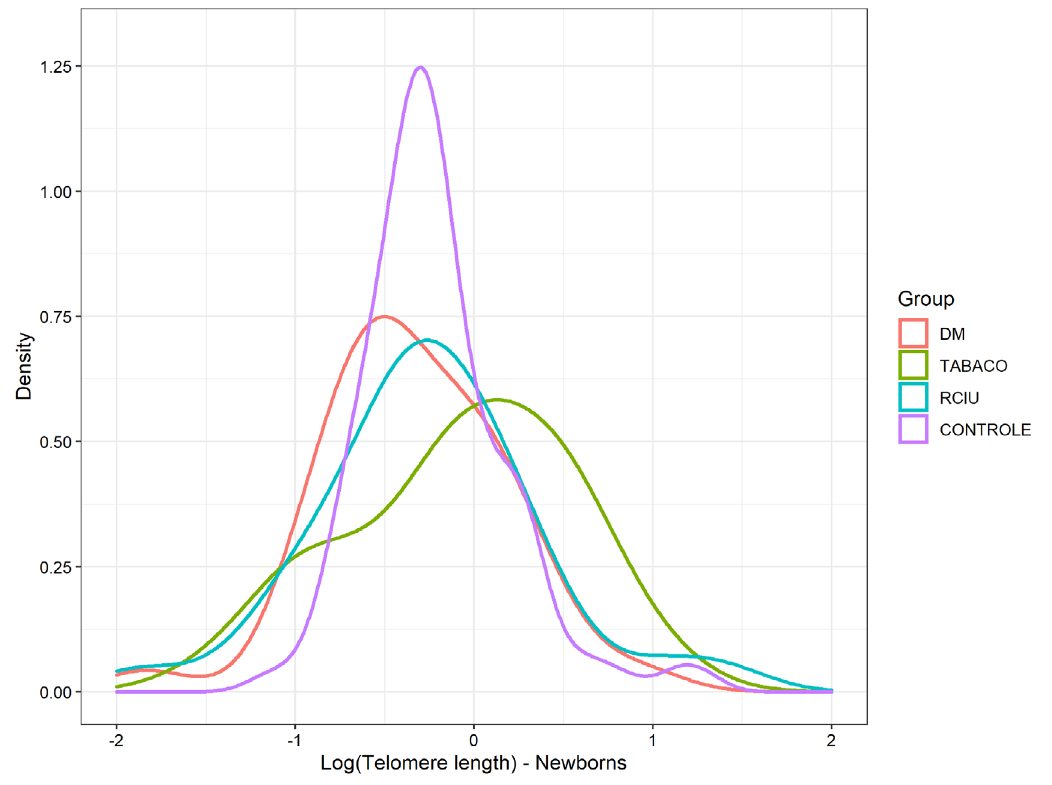
Figure 2 ‒ Telomere length of newborns among groups after adjustment age and newborn sex. p=0 . 110 (data from Table 2). Telomeres presented asymmetric distribution and underwent logarithmic